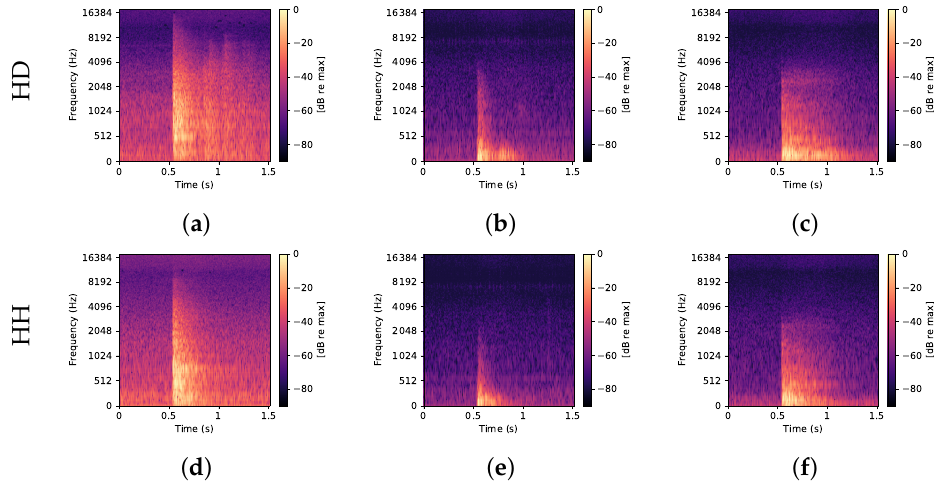
Figure 5. Time–frequency representations of inter-floor noise signals. ( a , d ) show HD and HH at the campus building. ( b , e ) show HD and HH in APT I. ( c , f ) show HD and HH in APT II. Table 3. F1 scores of source type classification tasks with t variation. The values in the parentheses are F1 scores when HH and HD are assumed to be the same